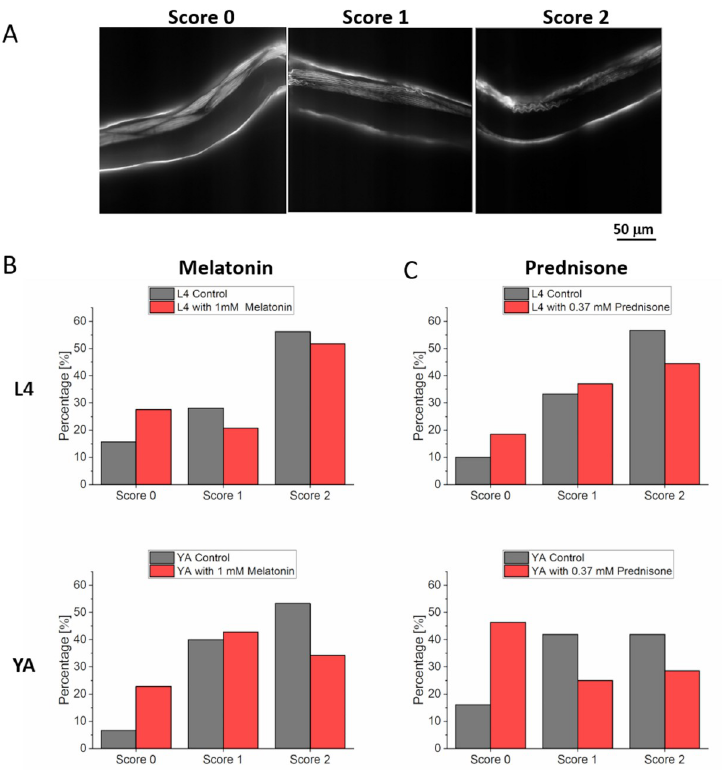
Fig 3. Morphology study of body wall muscle actin filaments for DMD model worm (LS587). The effect of drug treatment with prednisone on muscle morphology in young adult (YA) was studied using phalloidin staining. (A) Score 0 for DMD strain after treatment with prednisone showing smooth and parallel muscle fibers, score 1 for unhealthy muscle with minor waves in control group, and score 2 for damaged actin filaments with major wave like filaments in control group (nontreated). (B) Treatment with 1 mM melatonin for L4 stage and young adult stage both did not show any significant recovery (p = 0.49, p = 0.12). (C) Treatment with 0.37 mM prednisone in L4 stage did not show any significant recovery in muscle morphology (p = 0.54). However, in young adult a significant difference (p = 0.04) was measured. Significant differences were analyzed using chi-squared test. (Melatonin control, L4 stage, N = 32, drug treated N = 29; Melatonin control, YA, N = 30, drug treated N = 35; prednisone control, L4 stage, N = 30, drug treated N = 27; prednisone control, YA, N = 31, drug treated N =